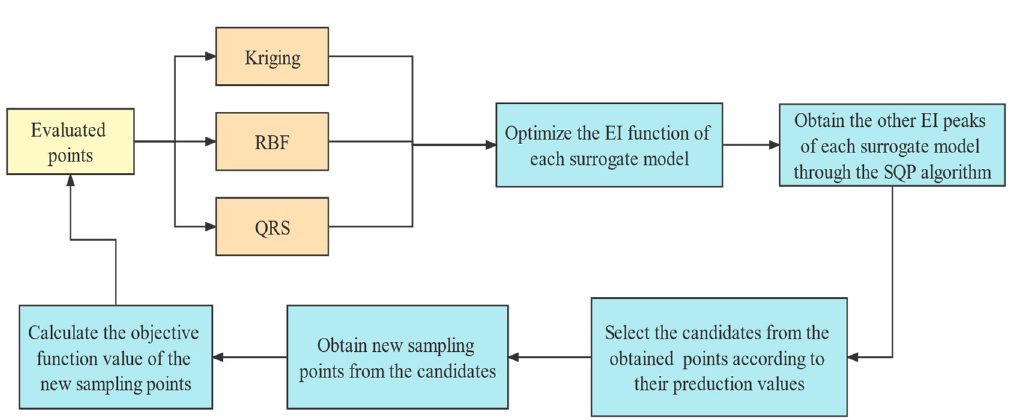
Figure 6. The process of selecting new sampling points using the multimodal EI criterion.